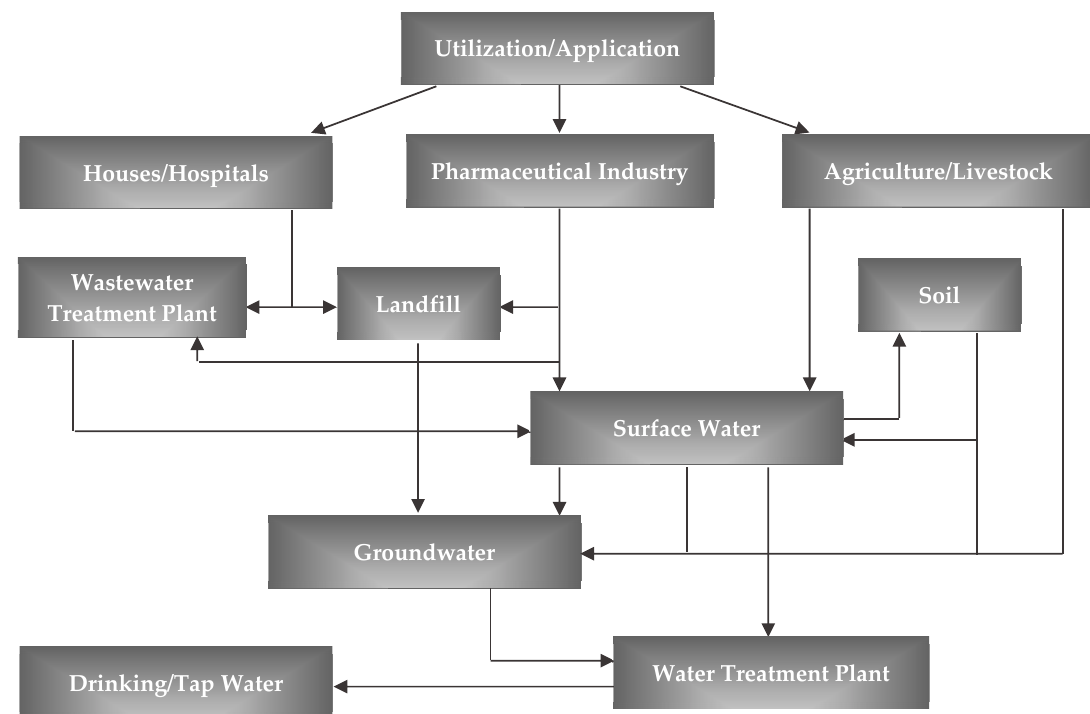
Figure 1. Pathways of pharmaceutical introduction into the environment.